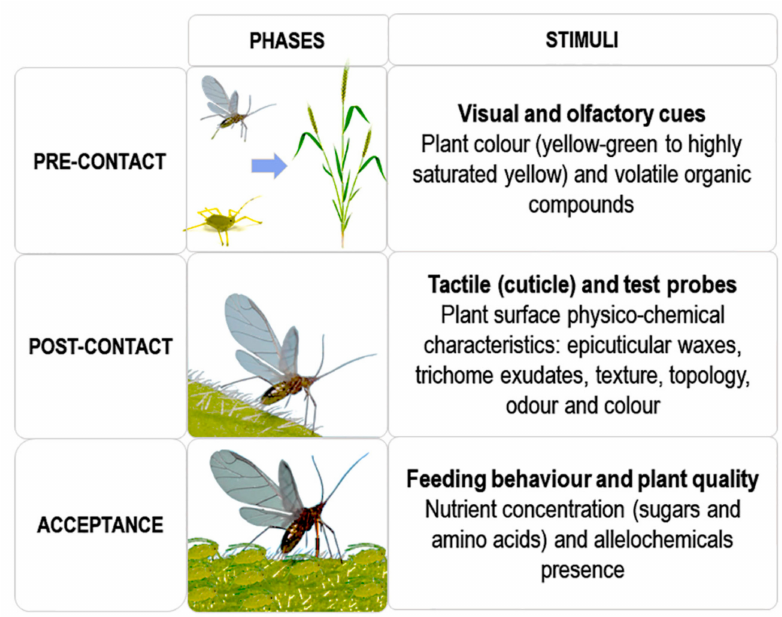
Figure 2. Summary of 3 phases of host-seeking behaviour and the stimuli involved, adapted from [14]. Bioassays assessing the pre-contact HSB of aphids are adapted according to the kind of insect morphotype. For example, pre-alighting behaviour is assessed in winged aphids [5]. This consists of tracking insect flight behaviour in response to visual and/or olfactory stimuli using a flight tunnel [18]. It has been established that aphids are able to target and land on yellow or yellow–green surfaces, but preferentially on highly saturated yellow surfaces under low wind conditions in the absence of plant odours [3,5,19]. Yet, yellowing is among the typical plant symptoms associated with phytovirus